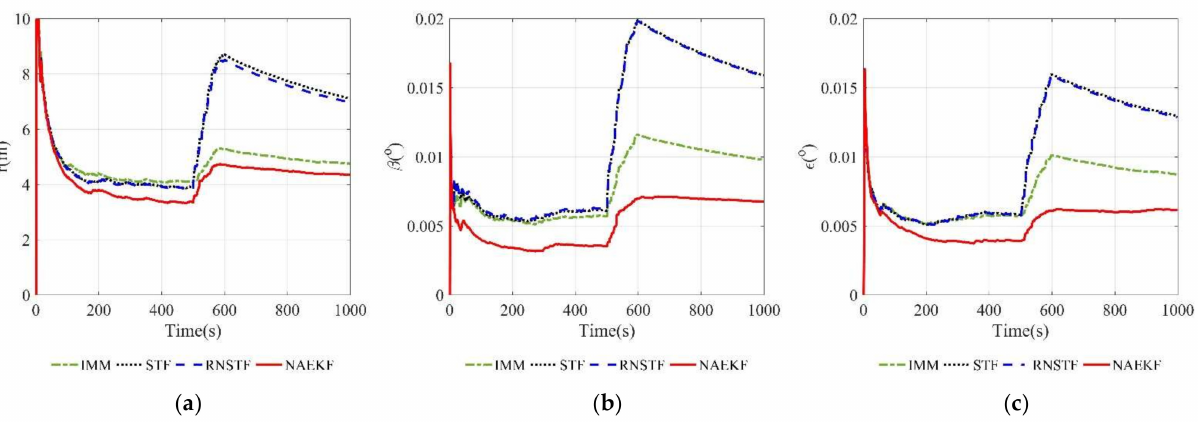
Figure 13. σ -Boundary of position estimation errors. ( a ) σ -Boundary of the range; ( b ) σ -Boundary of the azimuth angle; ( c ) σ -Boundary of the elevation